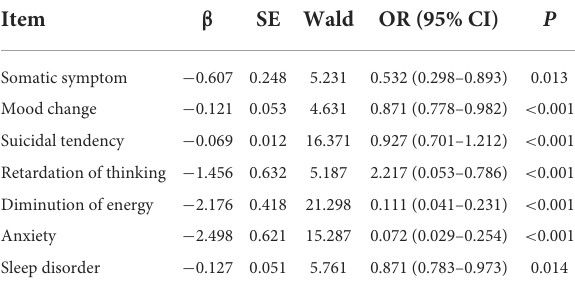
TABLE 3 Logistic regression analysis of influencing factors of cognitive function in patients with depressive